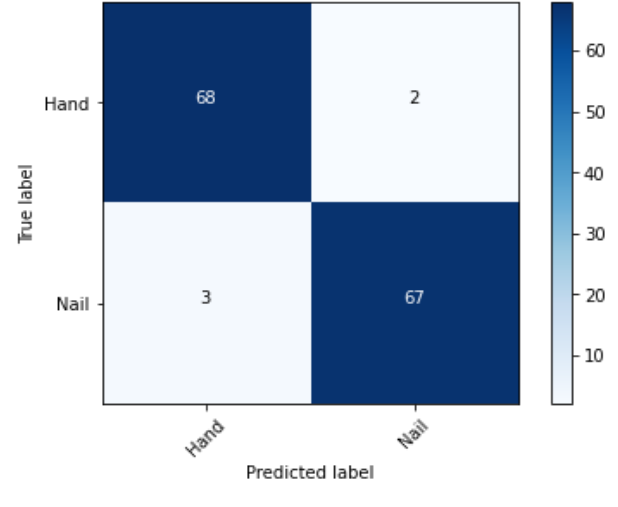
Fig. 14. Confusion matrix